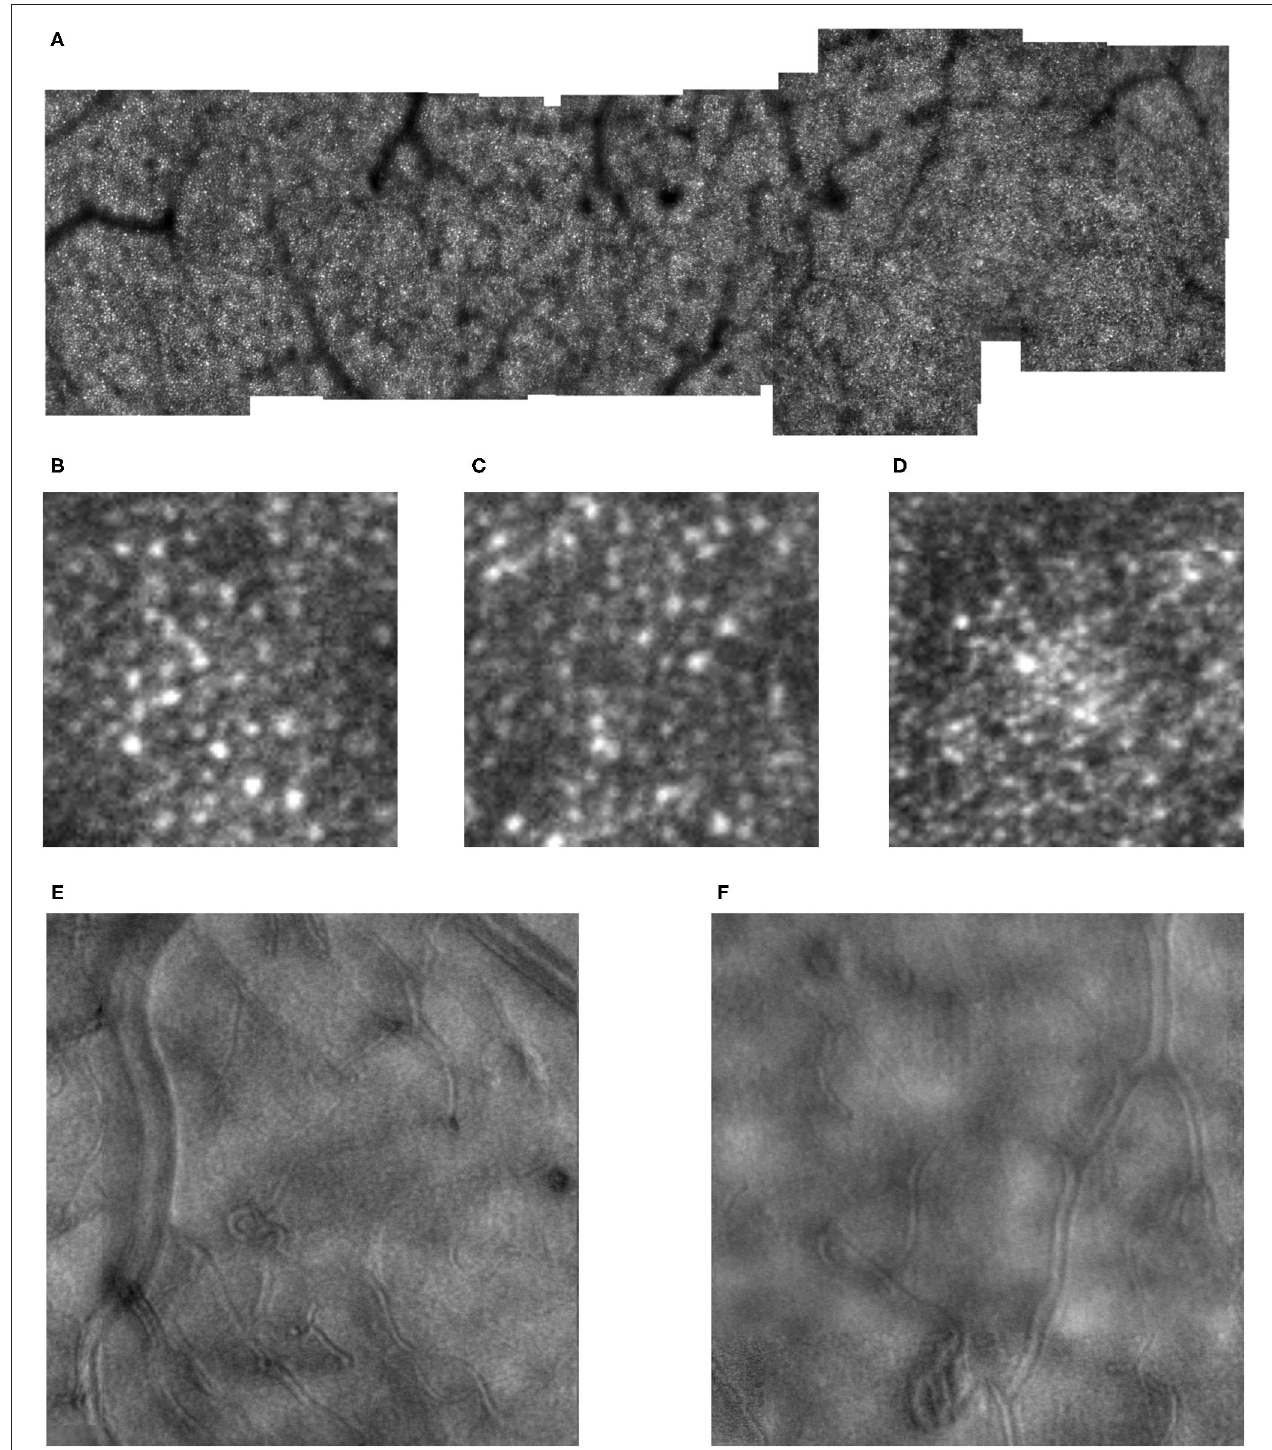
FIGURE 3 | Cone distribution for a 61 yr old female diabetic subject (A) , shown in a montage of cone images with the foveal region on the right, with a more moderate response to ischemia than in Figure 2 . Small white scale bar at lower left = 100 microns. There are microaneurysms, but less frequent capillary bends or loops, and few doubled or collateral vessels or the more complex tangles. (B–D) Magnified view of cones, showing the phenomena of both extra bright and dark cones in unusually large numbers in 100 × 100 micron samples of cones, with the upper far corner at 7.6, 5.6, and 1.0 deg temporal with respect to the fovea. (E,F) Enlarged views of the retinal microvascular layer, showing 500 × 500 microns samples of microaneurysms, capillary bends, and elongated and collateral vessels, but smaller or less frequent than in Figure 2 . Cone parameters, were a = − 0.00068, and b = 10.83, within normal limits. RMS fit = 0.791.